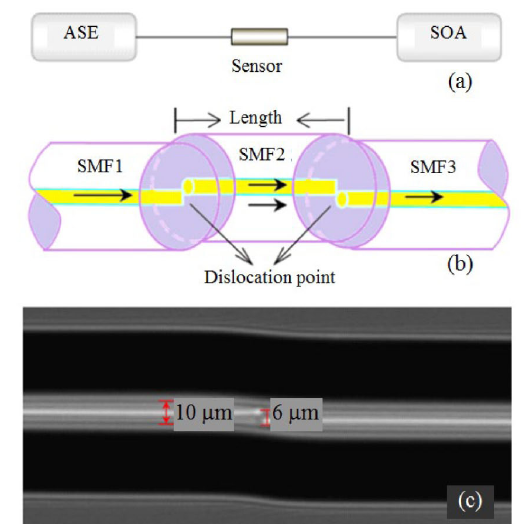
Fig. 1 Microscope image of the dislocation fiber: (a) schematic diagram of the proposed dislocation fiber MZI-based sensor measurement system, (b) schematic diagram of the dislocation fiber MZI-based sensor, and (c) microscope image of the point of dislocation fiber (6 μm ).